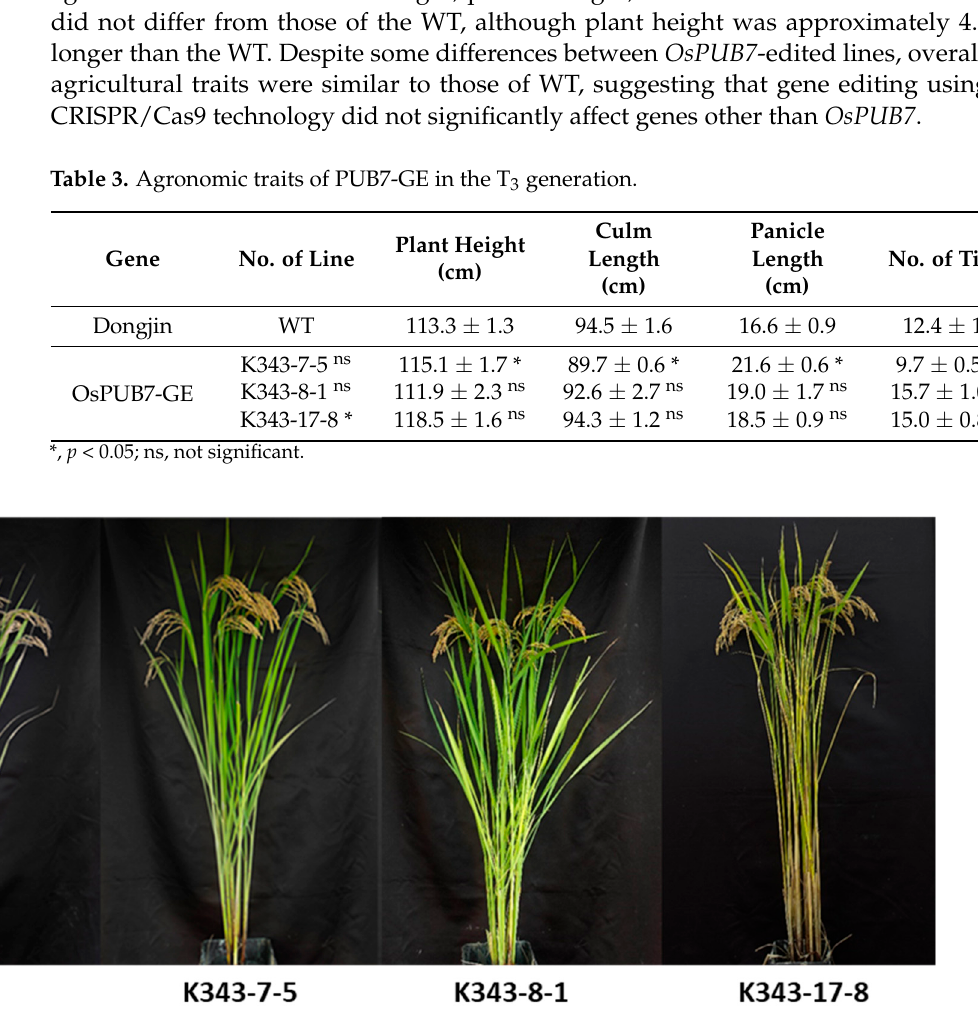
Figure 16. Phenotypes of selected PUB7-GE in the T 3 generation.